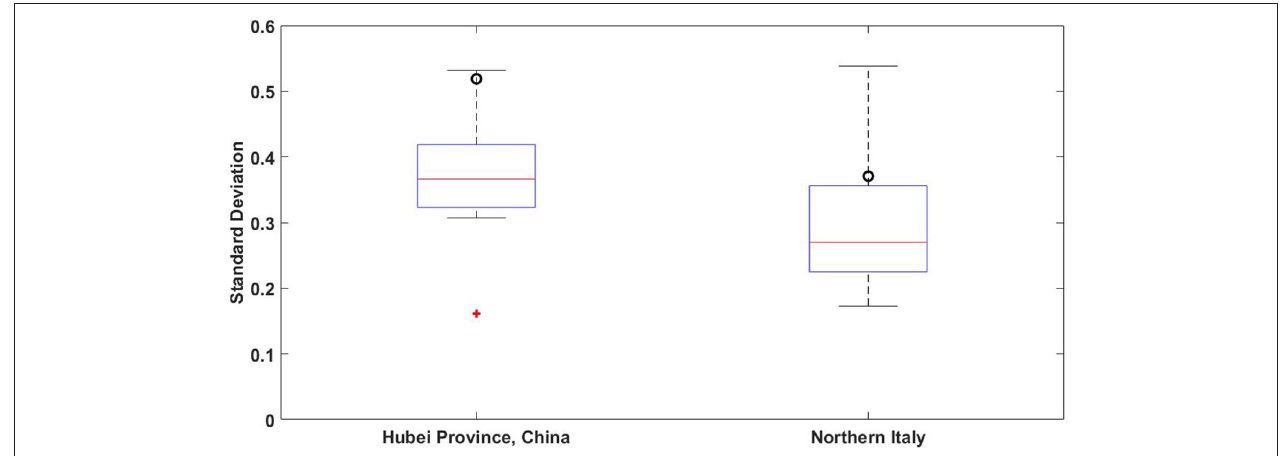
FIGURE 3 | Boxplot of standard deviations (in mm/hr) computed for each Spring of 2001–2019 for the Hubei province and Northern Italy. The central red mark indicates the median, and the bottom/top edges indicate the 25th/75th percentiles, the whiskers show the most extreme points not considered outliers, whereas the red crosses represent outliers from 19 years data of standard deviations. The black circles indicate the corresponding standard deviations for Spring 2020.